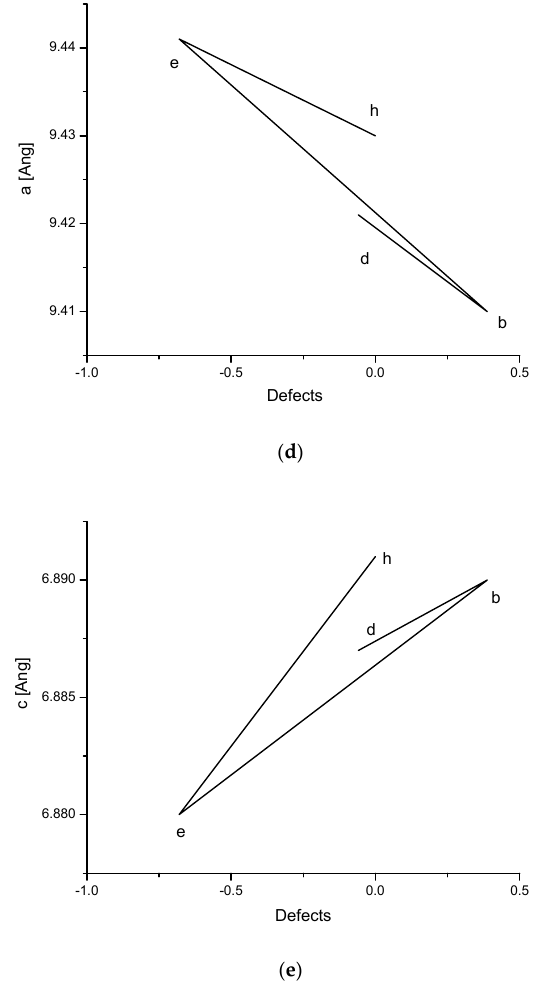
Figure 3. ( a ) Distribution of charges (defects) in different phases of bioapatites; ( b ) distribution of values of crystallographic parameter “ a ”; ( c ) the same for parameter “ c ”; ( d , e ) relationships of parameter “ a ”, “ c ” on charge of defects. Letters denote, respectively: b—bone; d—dentin; e—enamel; h—hydroxyapatite. (The solid lines linking points in the figures are eye guides rather than real relationships).